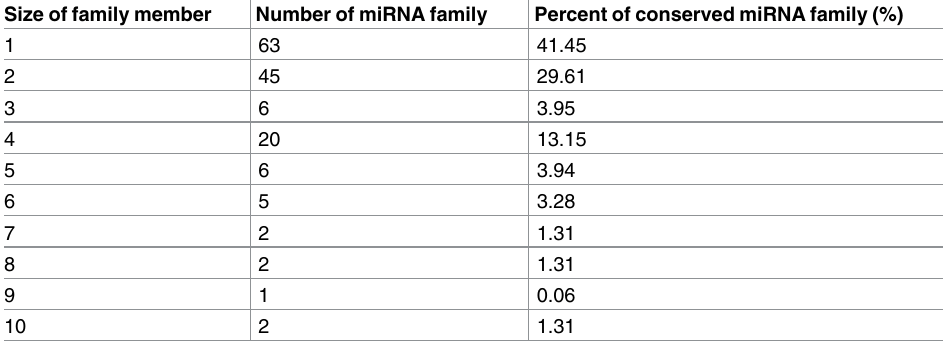
Table 1. Number of member in each identified conserved miRNA